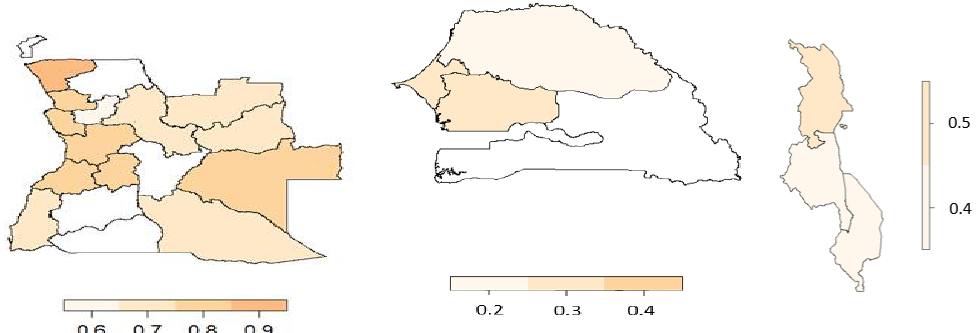
Figure 8. Joint probability of a child being not malnourished and anaemic. ( Left ) Angola, ( middle ) Senegal, and ( right ) Malawi.